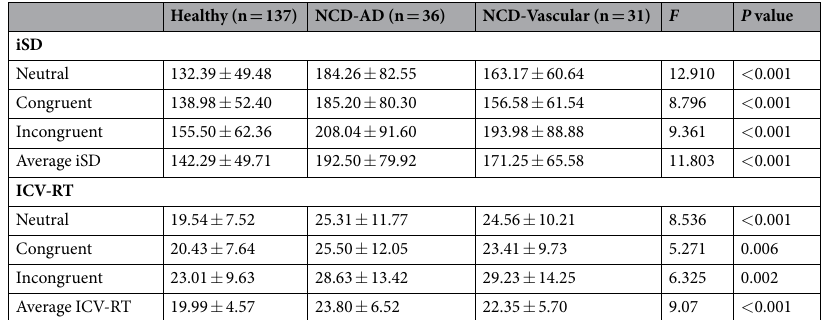
Table 3. Indices of intra-individual variability of RT between healthy and NCD subgroups.